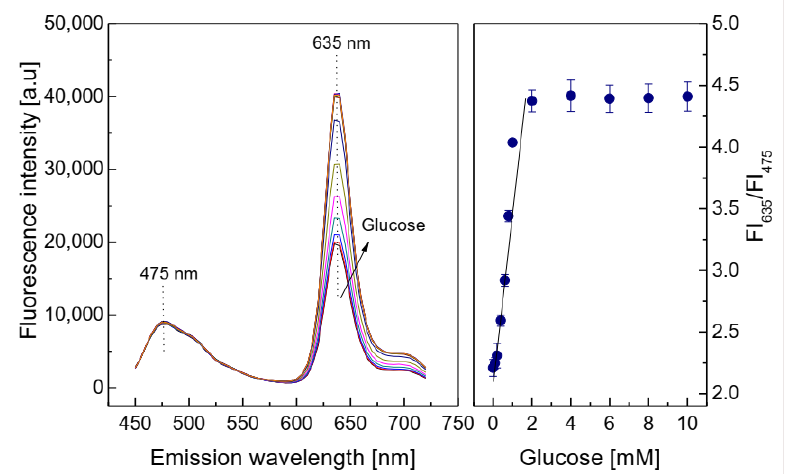
Figure 4. Response of the glucose-sensing membrane at different glucose concentrations, and calibration curve for glucose as determined by the ratio of FI 635 /FI 475 .